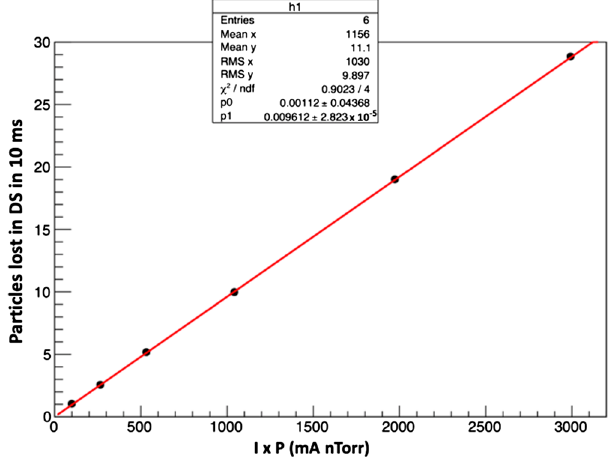
FIG. 5. Simulated behavior of the subset of bremsstrahlung losses detected in the DS as a function of the product of beam current and vacuum pressure.